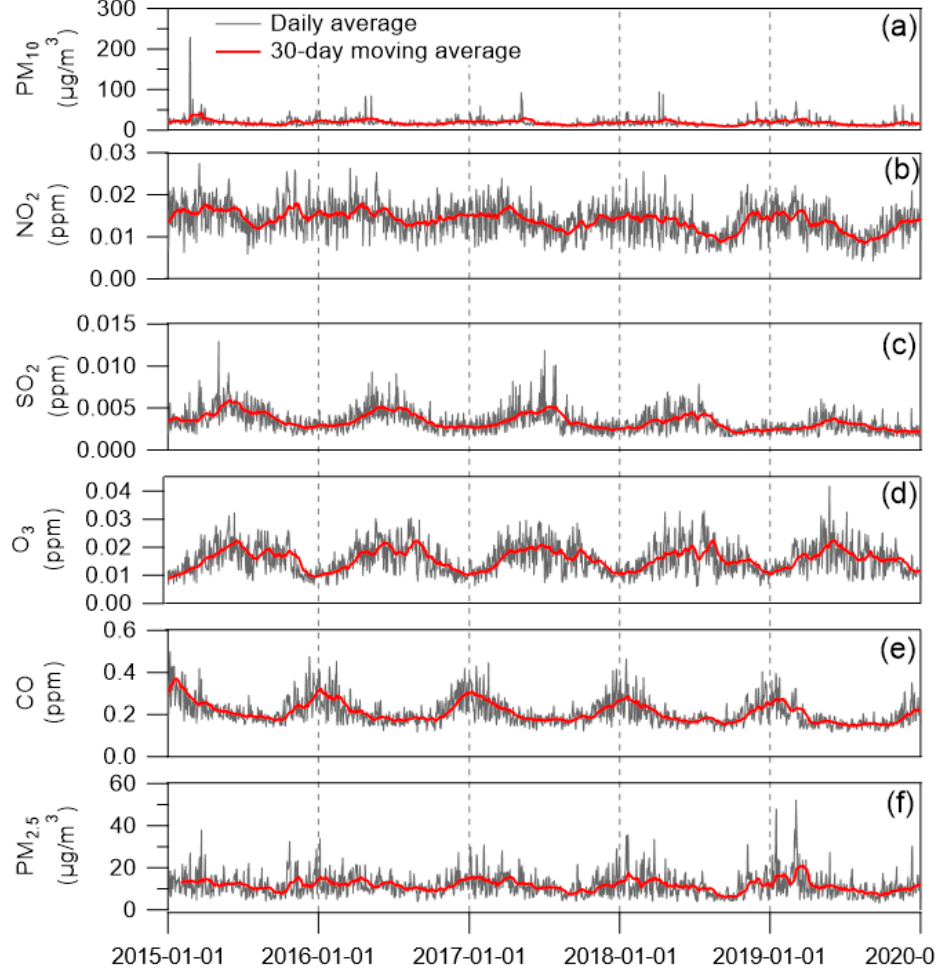
Figure 3. Daily standard deviation and 30 − day moving average for ( a ) PM 10 , ( b ) NO 2 , ( c ) SO 2 , ( d ) O 3 , ( e ) CO, and ( f ) PM 2.5 . Table 5. Statistical description of daily meteorological factor,